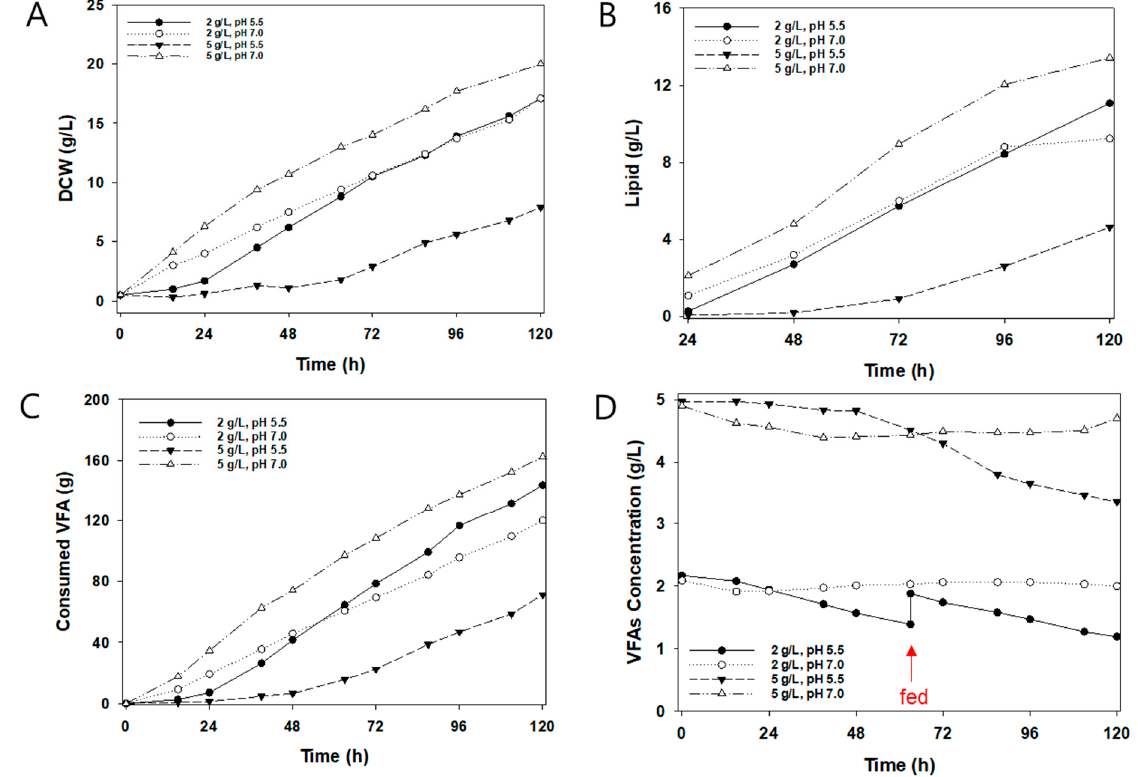
Figure 4. Effects of initial VFA concentration and pH on the growth of C. curvatus using the auto- matic fed-batch mode cultivation: ( A ) dry cell weight, ( B ) lipid, ( C ) consumed VFA, and ( D ) VFA concentration in broth. The red arrow indicates when a VFA was added .